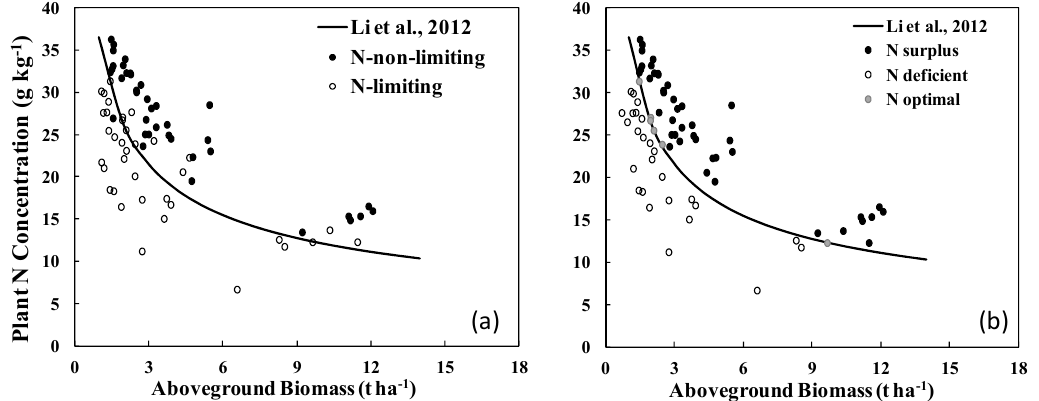
Figure 3. Evaluation of the existing critical N dilution curve for spring maize in Northeast China using plant N concentration and biomass data under N-limiting and non-N-limiting conditions ( a ); and under N deficient (nitrogen nutrition index (NNI) < 0.95), N optimal (0.95 ≤ NNI ≤ 1.05) and N surplus (NNI > 1.05) conditions ( b ). The critical N dilution curve was developed for spring maize by Li et al. [24] (N c = 36.5 W − 0.48 ).